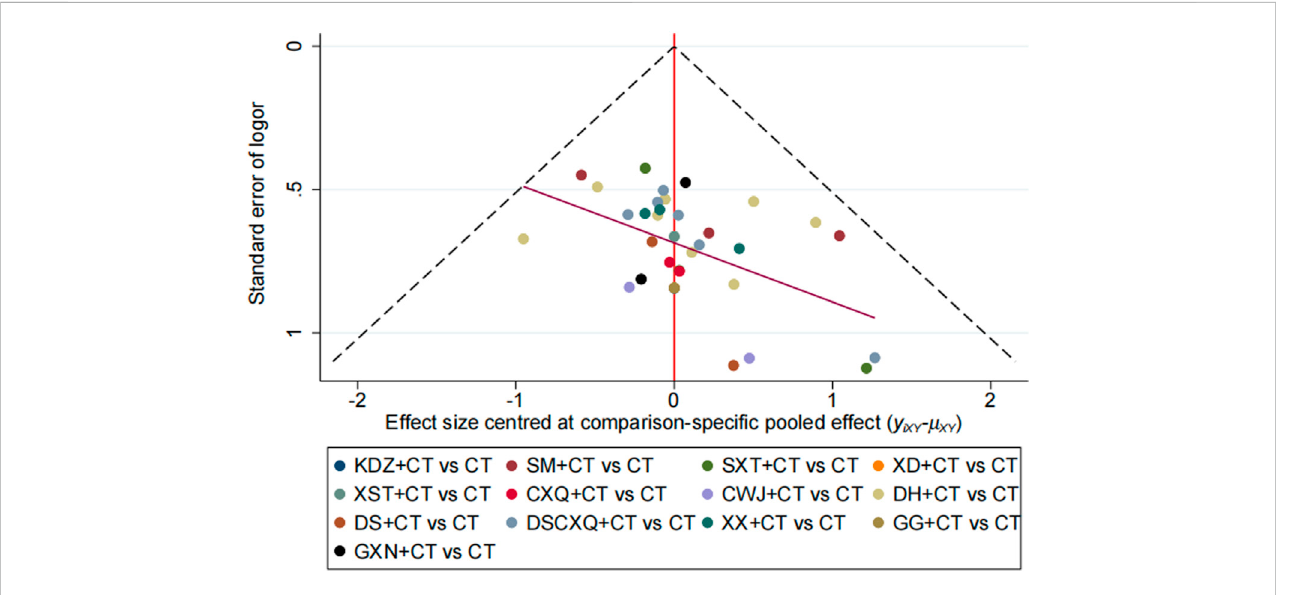
FIGURE 6 Funnel plot for total effective